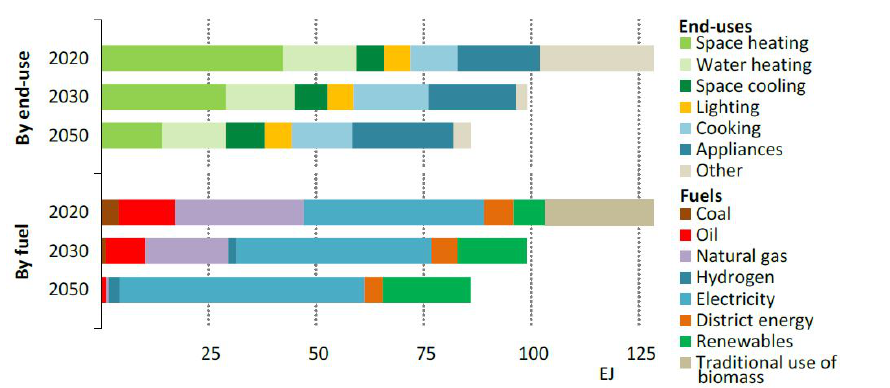
Figure 3. Global final energy consumption from fuel and end-use applications in buildings in the NZE